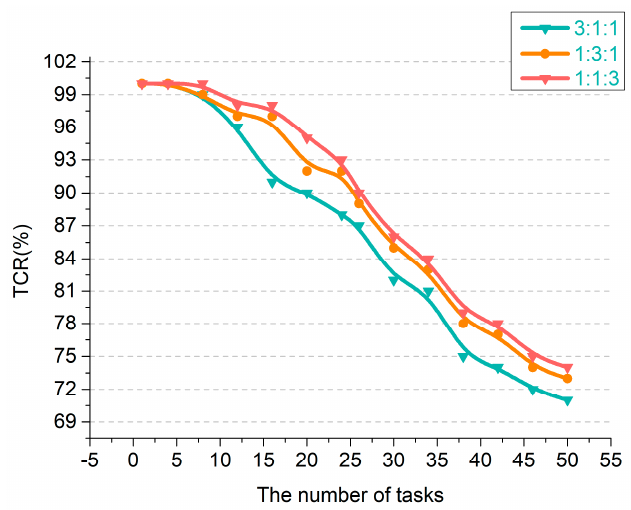
Figure 5. The TCR of different proportions of tasks.